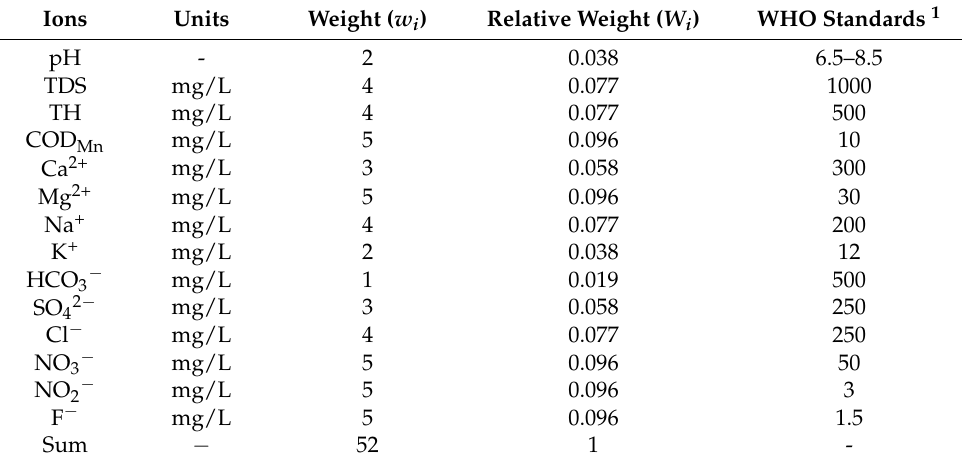
Table 2. Weight ( w i ) and relative weight ( W i ) of each